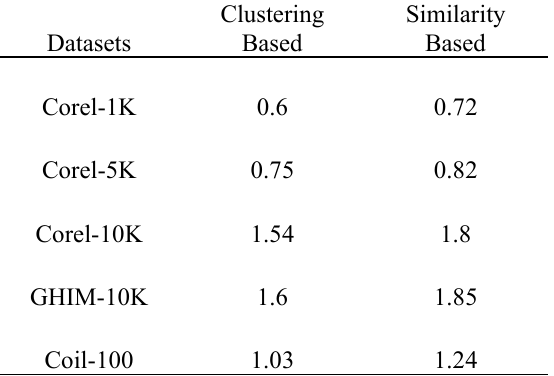
Table 3. Time taken for retrieval of images in both indexing techniques (in seconds